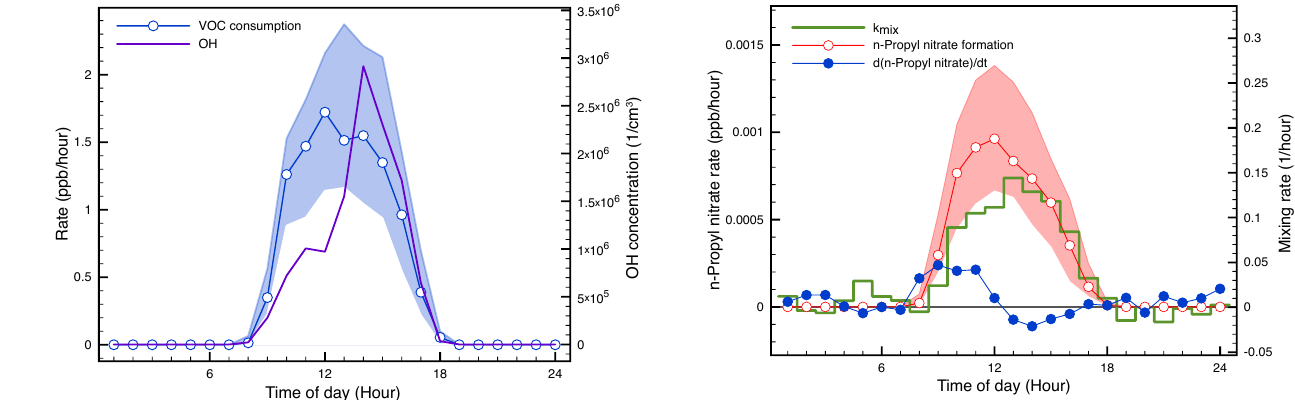
Figure 4. Calculated daytime median profiles of the VOC consump- tion rate and the OH concentration. The VOC consumption rate is controlled by the photolysis rate leading to OH and HO 2 radical formation, while OH concentration is regulated by the OH reactiv- ity dominated by the NO x and VOC concentrations.